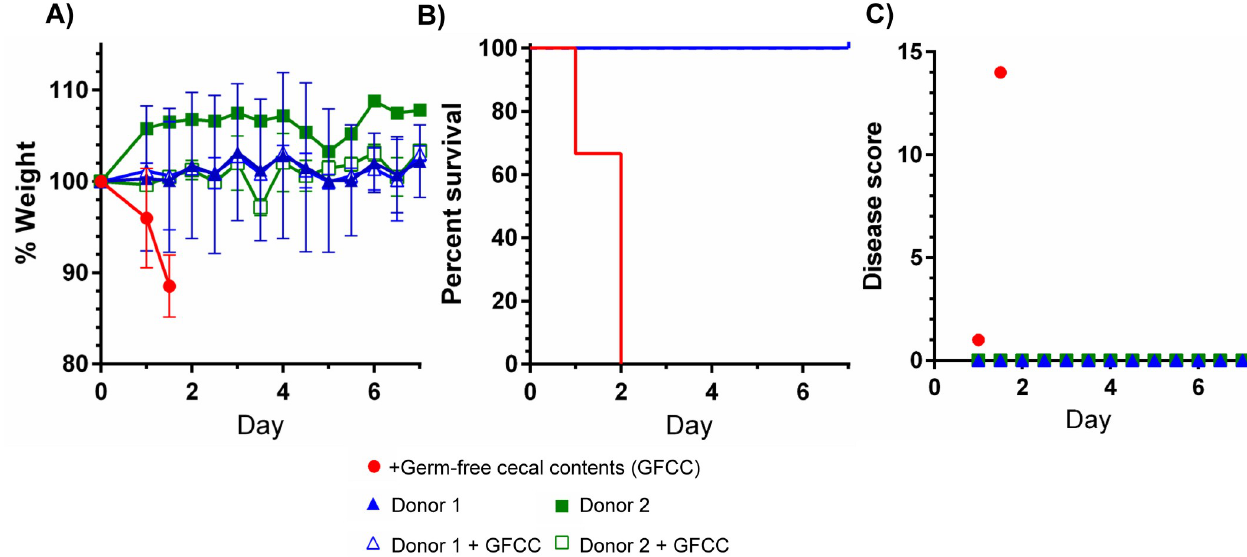
Fig 6. Fecal microbial therapy protects mice independent of cholic acid class bile acids. Germ-free Cyp8b1 -/- given cecal contents derived from a germ-free donor (GFCC) (N = 3) or mice colonized with human stool donor #1 with (N = 3) or without GFCC (N = 3) and human stool donor #2 with (N = 2) or without GFCC (N = 1) were infected with 10 4 spores derived from the C . difficile VPI10463 strain. Weight loss (A) or Kaplan-Meier survival curve (B) or disease scores (C) are illustrated.